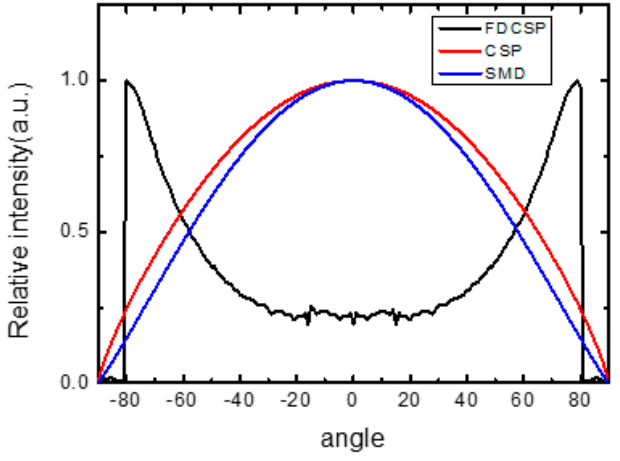
Figure 3. View angle of CSP, SMD, and FDCSP.